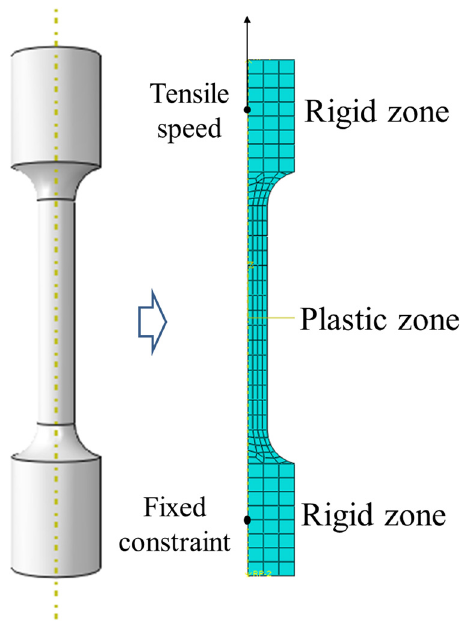
Figure 7: FE model and boundary condition of the uniaxial tensile simulation.